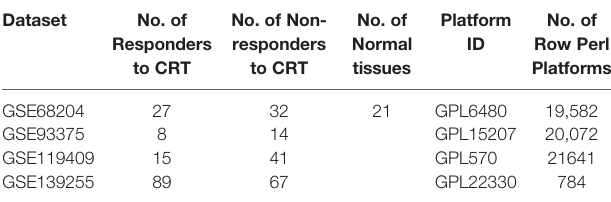
GSE, Gene Expression Omnibus Series; GPL, Gene Expression Omnibus Platform.